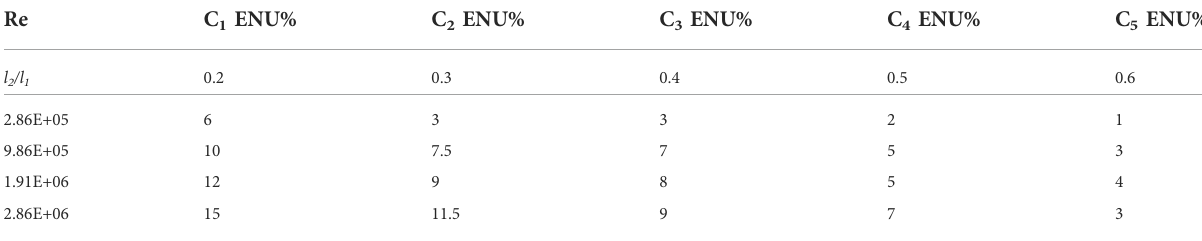
TABLE 3 %ENU variations for different con fi